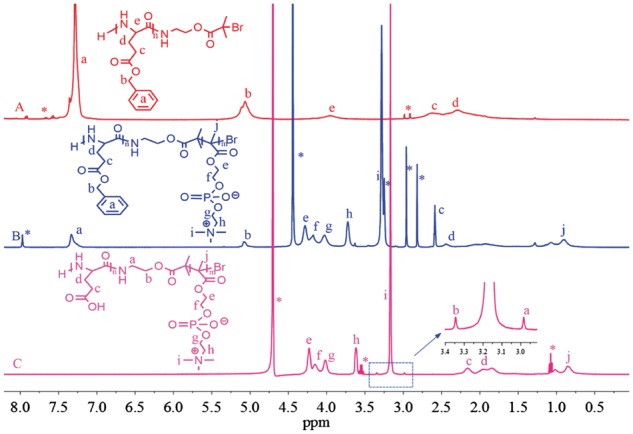

1H NMR Spectra of PBLG-Br (A) in DMSO-d6, PBLG-b-PMPC (B) in CD3OD and DMSO-d6 (1/1, V/V) and PLG-b-PMPC (C) in D2O